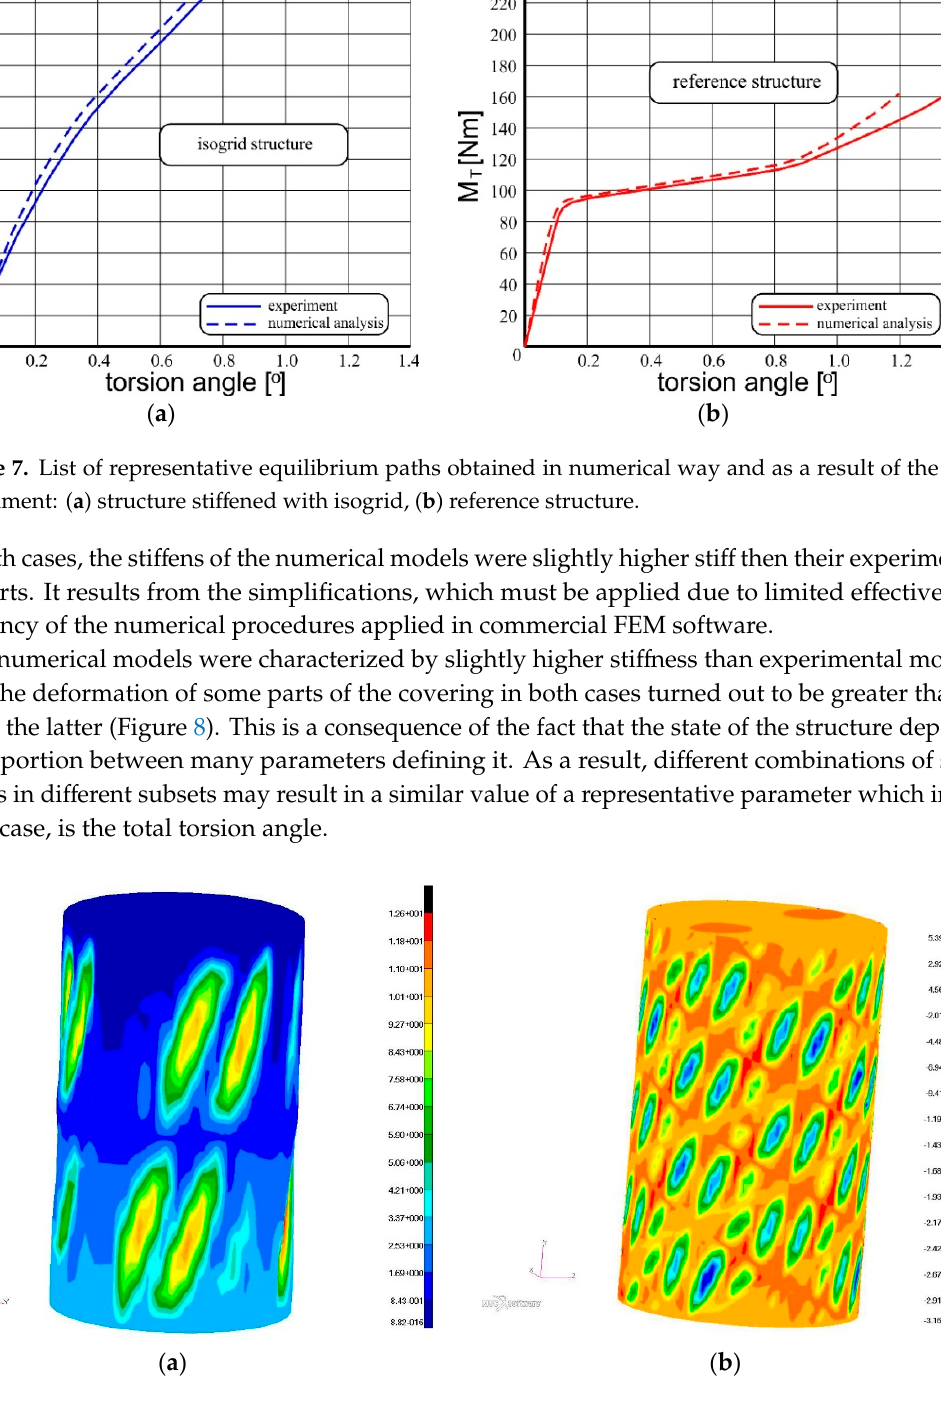
Figure 8. Distributions of the radial deformation component at the maximum load value: ( a ) reference structure, ( b ) structure with isogrid.